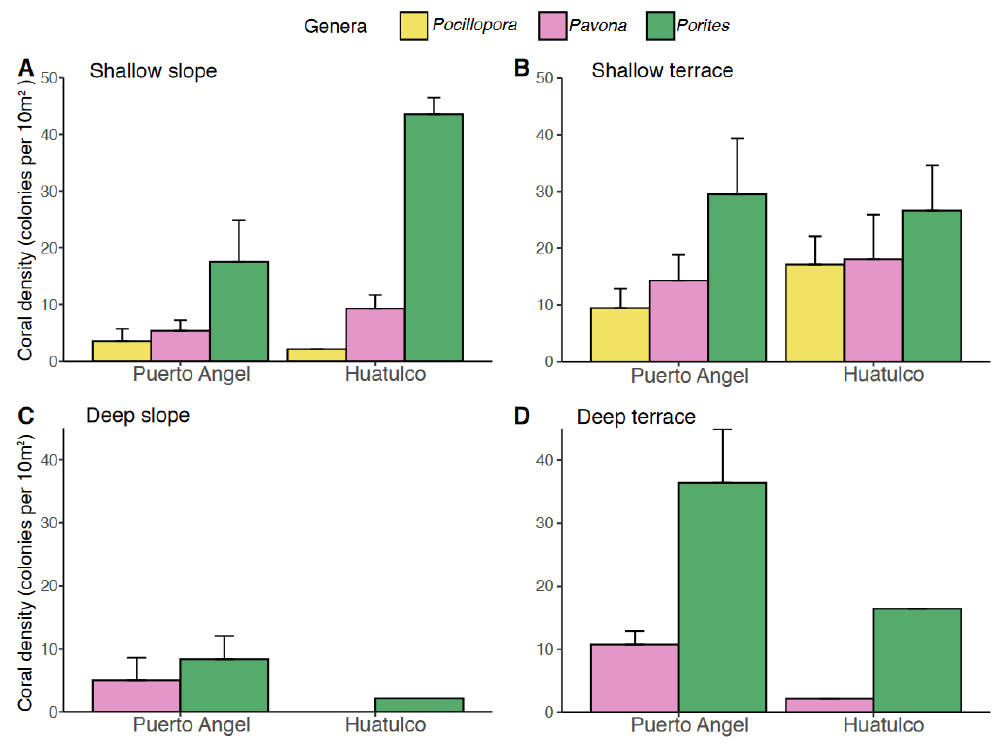
Figure 6. Variations in coral density at the different seascapes characterized: ( A ) shallow slope; ( B ) shallow terrace; ( C ) deep slope; and ( D ) deep terrace; in the three genera: Pocillopora (yellow), Pavona (pink) and Porites